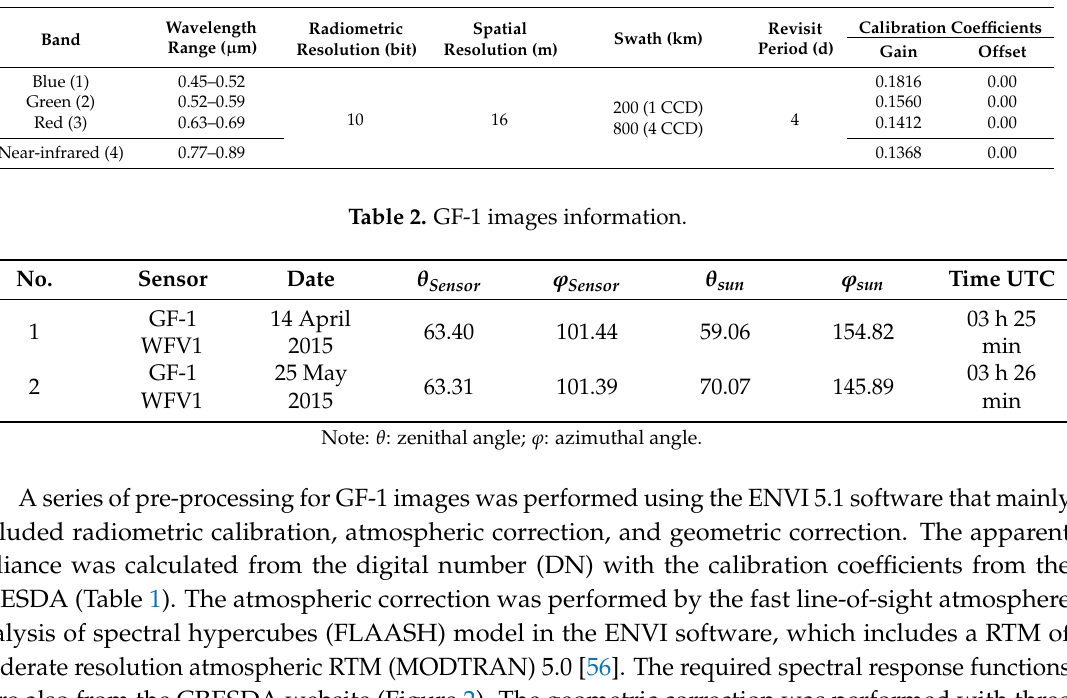
Table 1. Sensor specifications and calibration coefficients of GF-1 WFV.